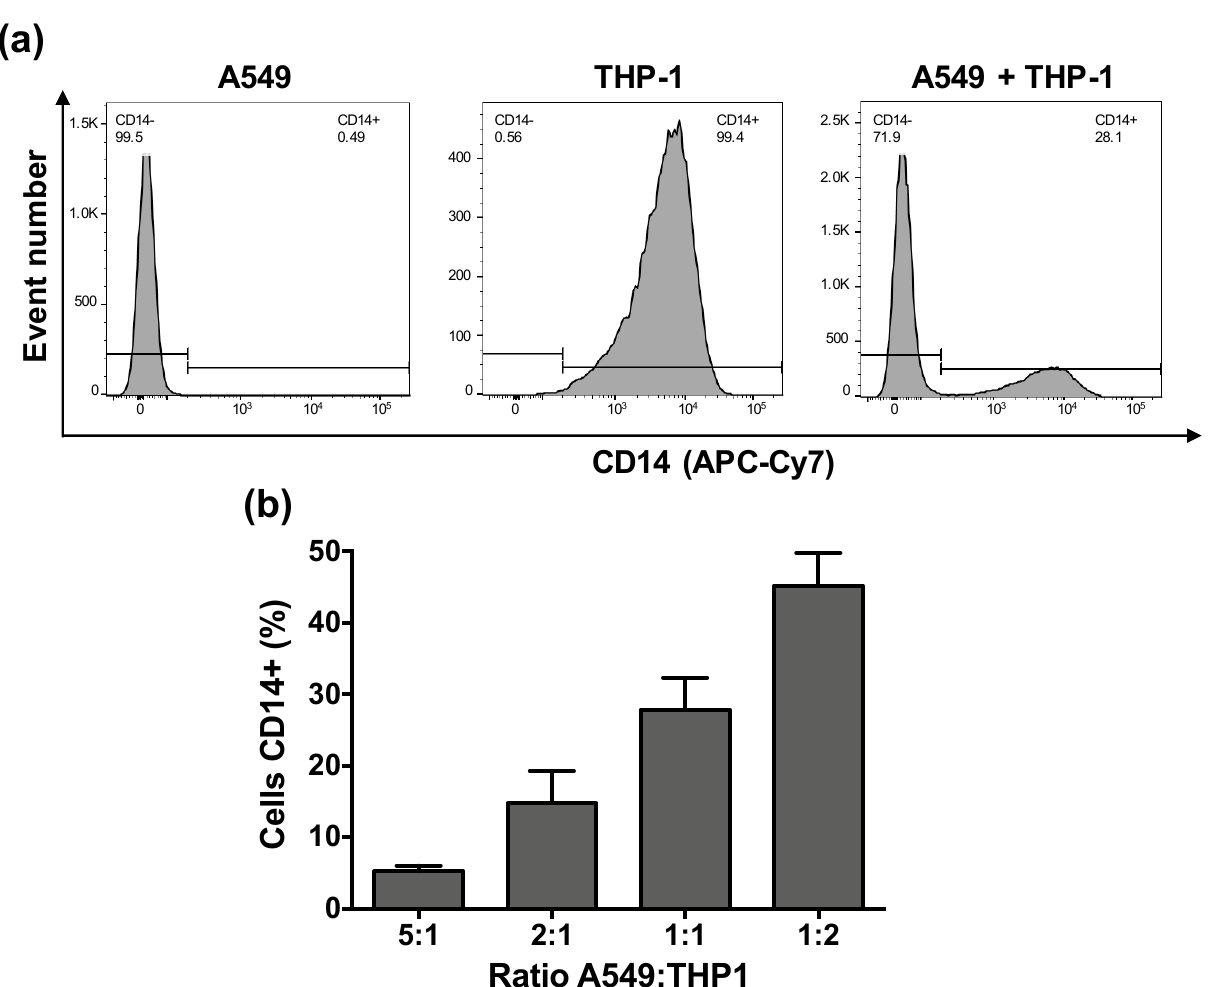
Figure 2. Determination of the proportion of macrophages in the co-culture models by FACS. ( a ) Staining and gating strategy to discriminate the A549 epithelial cells (CD14-) from the THP-1-derived macrophages (CD14+). ( b ) Proportion of macrophages (CD14+ cells) within the co-culture according to the A549:THP-1 seeding ratio two days after THP-1 seeding. Data are means ± SEM of n = 3